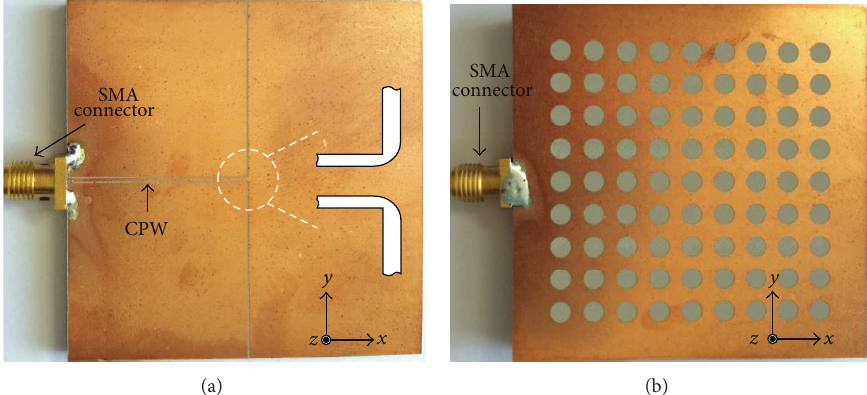
Figure 11: Photographs of the fabricated antenna with (a) a top view of the feeding structure and (b) a bottom view of the FSS.